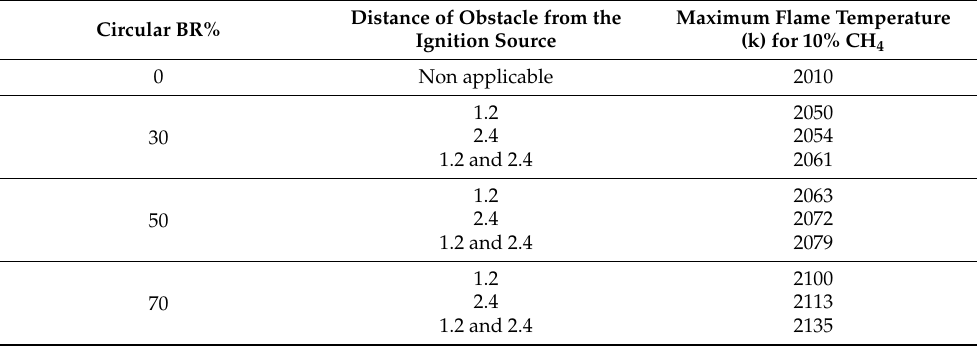
Table 3. Maximum flame temperature (K) as a function of obstacle blockage ratio (BR%) and location (obstacle distance in metres from ignition source) for a 10% methane concentration in a straight